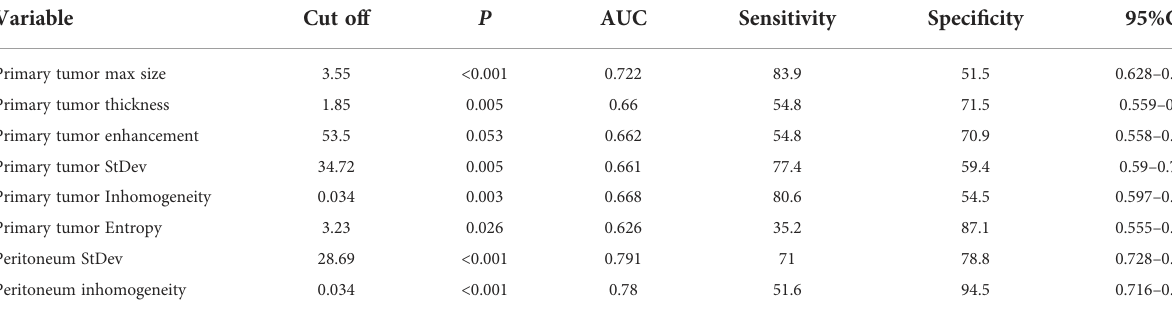
TABLE 2 Receiver operating characteristic curves of every continuous variable.